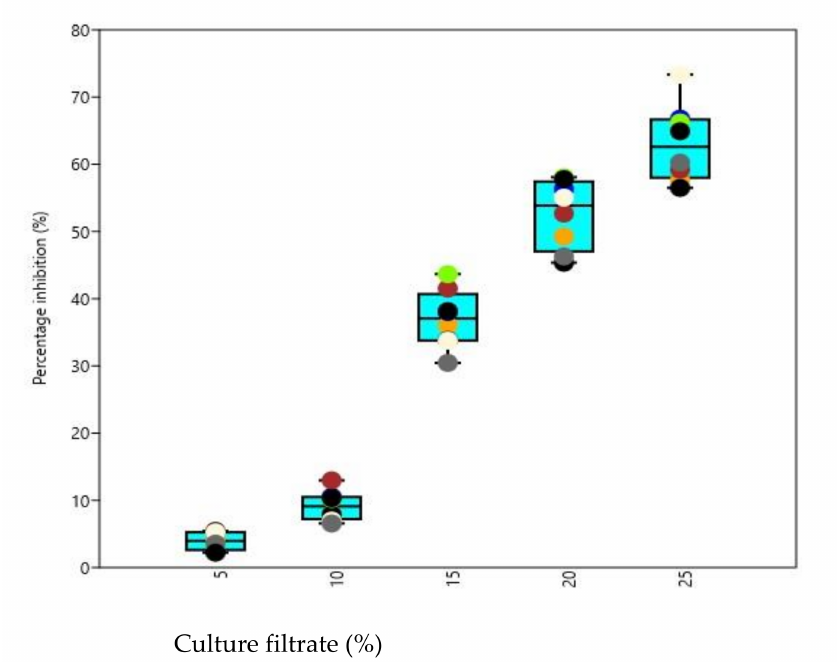
Figure 7. Box and Jitter plot representing percentage inhibition of F. oxysporum by various chitinase producing Trichoderma isolates. [Symbols in the plot represent: AT2: Orange; AT3: Black; AT7: Blue; BT1: Brown; BT3: Cornsilk; BT4: Chartreuse; BT7: Dim gray; BT8: